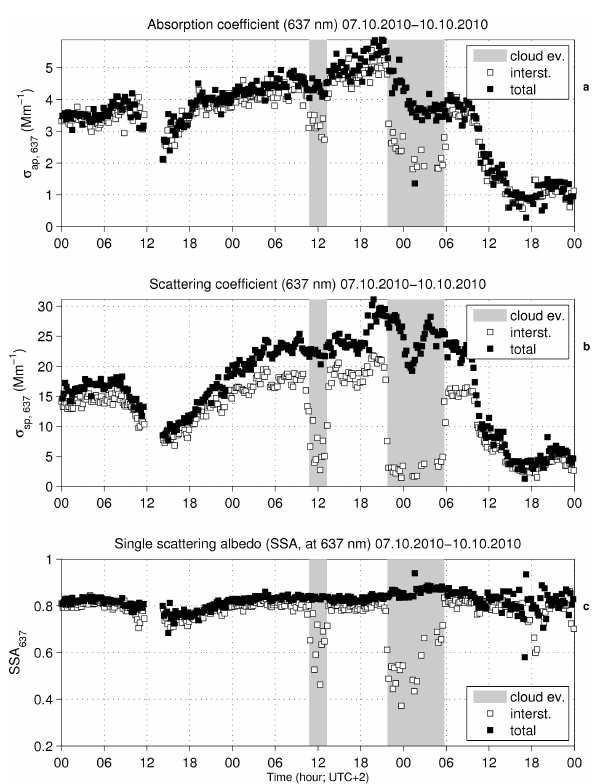
Fig. 10. The (a) total scattering coefficient at 637nm, (b) absorp- Fig. 10. 749 tion coefficient at 637nm, and (c) single scattering albedo at 637nm (SSA 637 ) of total and interstitial (interst.) aerosol particles at Puijo 7–11 October 2010, when two cloud events (cloud ev.) took